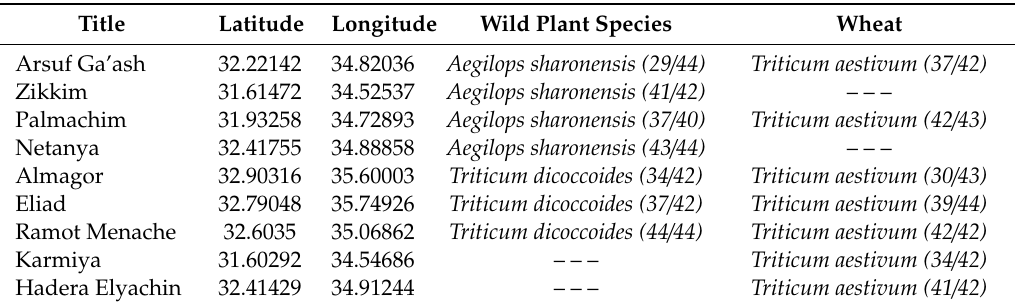
Table 1. List of sampling locations. The numbers in parenthesis show: left, actual number of samples that were used in statistical analysis; right, total number of plants that were sampled in each